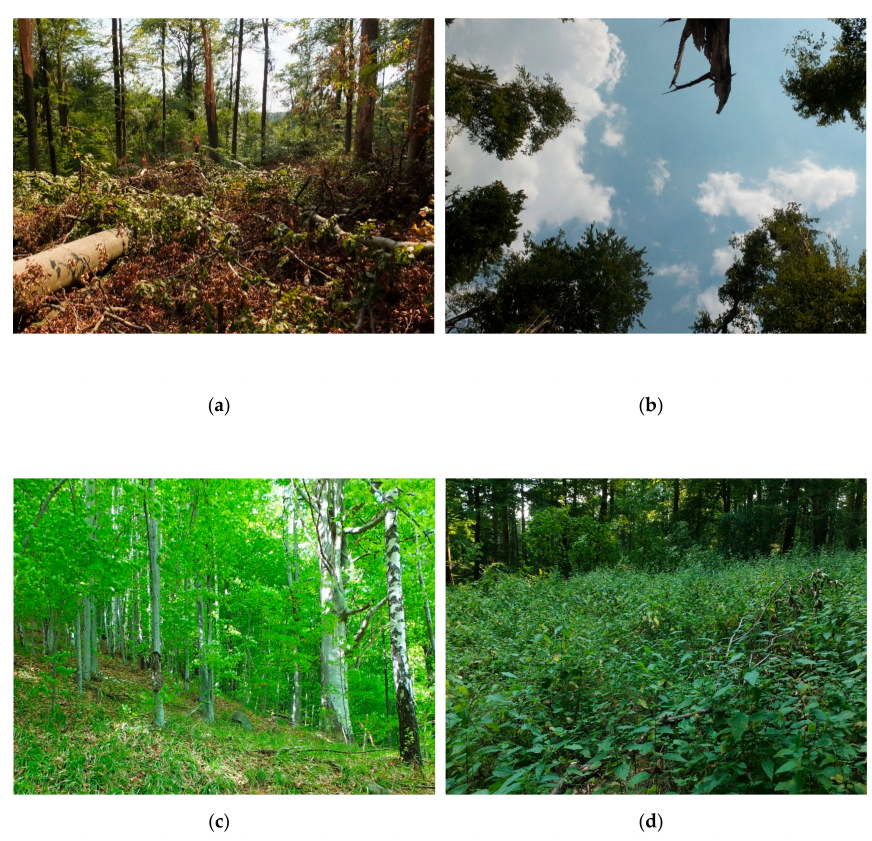
Figure 3. Disturbance ecology will play an increasingly pivotal role in vegetation dynamics. For example, we must face an increased frequency in European windstorms ([33], (pp. 235–239). Mosaics of forest disturbance and succession: ( a ) uprooted competitors ( Fagus sylvatica L.), ( b ) canopy patchiness, ( c ) pioneer trees ( Betula pendula Roth), ( d ) R-strategists ( Urtica dioica L.). Photographs by H. Walentowski /